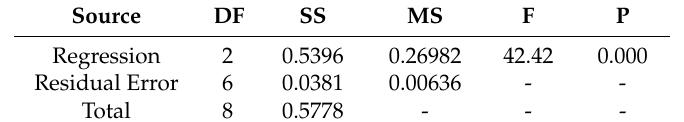
Table 8. Analysis of variance.